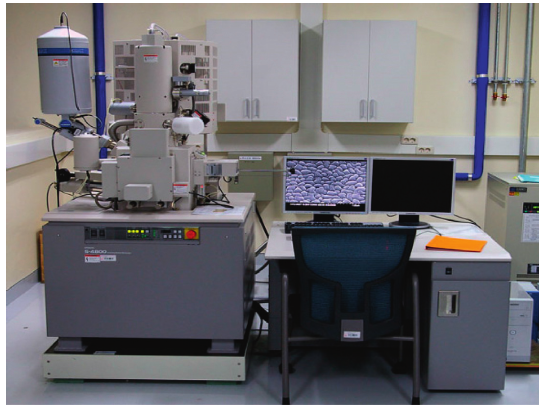
Figure 4: ScanningElectron Microscope.